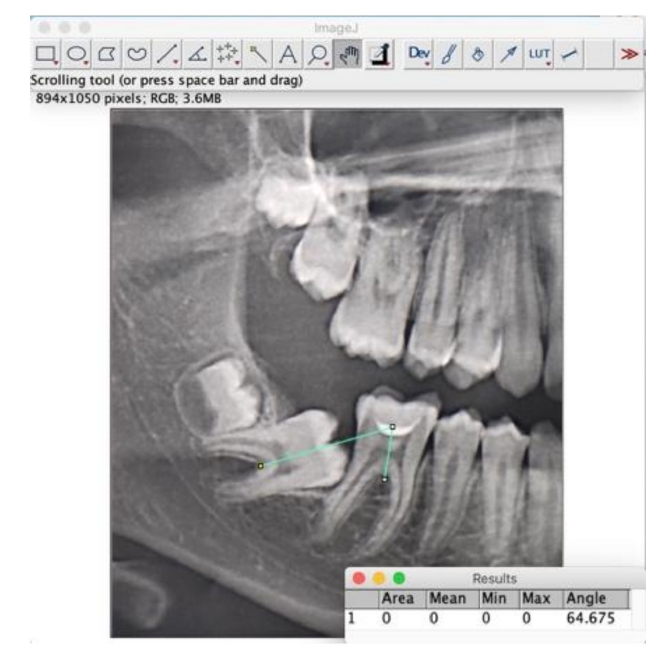
Figure 4. Radiographic measurement performed using ImageJ